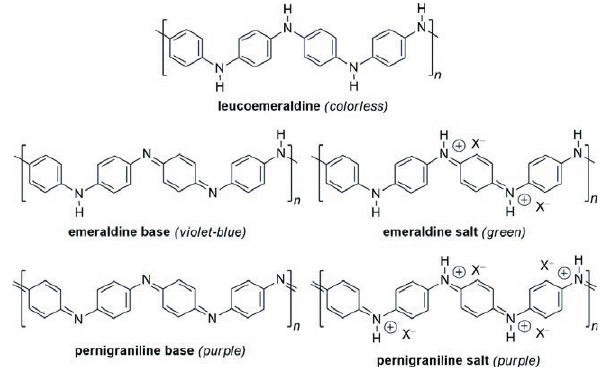
Figure 2. Various common forms of